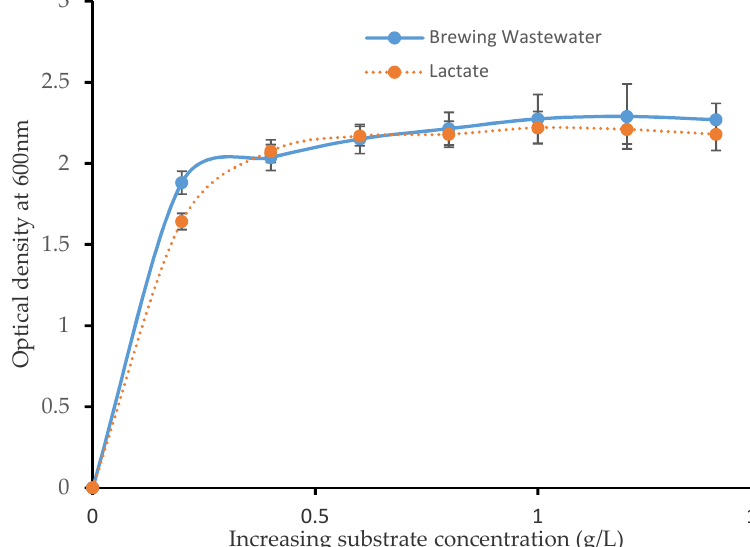
Figure 2. Effect of carbon substrate limitation on the sulphate-reducing bacteria (SRB) consortium’s growth.